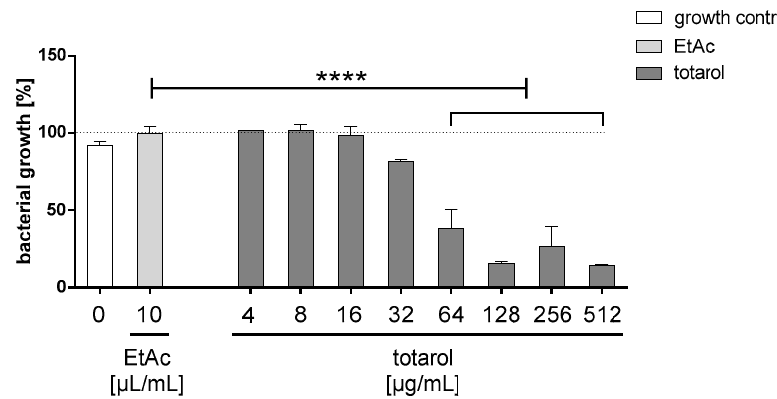
Figure 1. The Minimal Inhibitory Concentration (MIC) was established using the macrodilution method ( n = 3) according to the Clinical and Laboratory Standard Institute (CLSI) standard M07-A9. A significant decrease in bacterial growth after 24 h was detected when totarol concentrations of 64 µg/mL or higher were used. Data are given as means with standard error of the mean (SEM). One-way RM (repeated-measures) ANOVA followed by Tukey´s multiple comparisons test was used to identify significant differences between the varied totarol concentrations. **** indicates that the results are significantly different compared to the EtAc control ( p < 0.0001). The white bar shows the growth control; the light grey bar depicts bacterial growth in the presents of EtAc and the dark grey bars display the growth of S. aureus exposed to different concentrations of totarol.